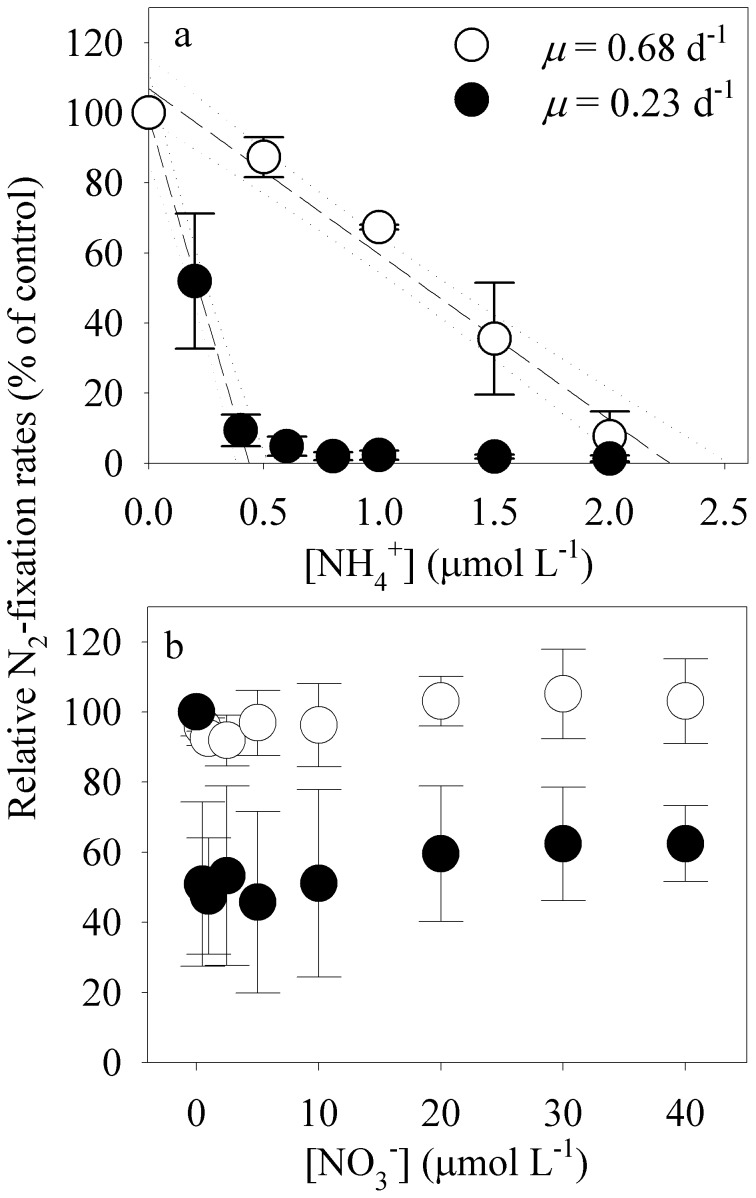
Short-term inhibitory effects of ammonium (NH4
+, 0–1.5 µmol L−1) and nitrate (NO3
−, 0–40 µmol L−1) on N2 fixation by Crocosphaera watsonii (WH0003) (percent of control with no added nitrogen).Cultures were grown in steady state under high light (175 µmol quanta m−2 s−1, growth rate (µ) = 0.68 d−1, open symbols) and low light (25 µmol quanta m−2 s−1, µ = 0.23 d−1, closed symbols) before adding nitrogen. Error bars represent standard deviations on means from 3 culture replicates.